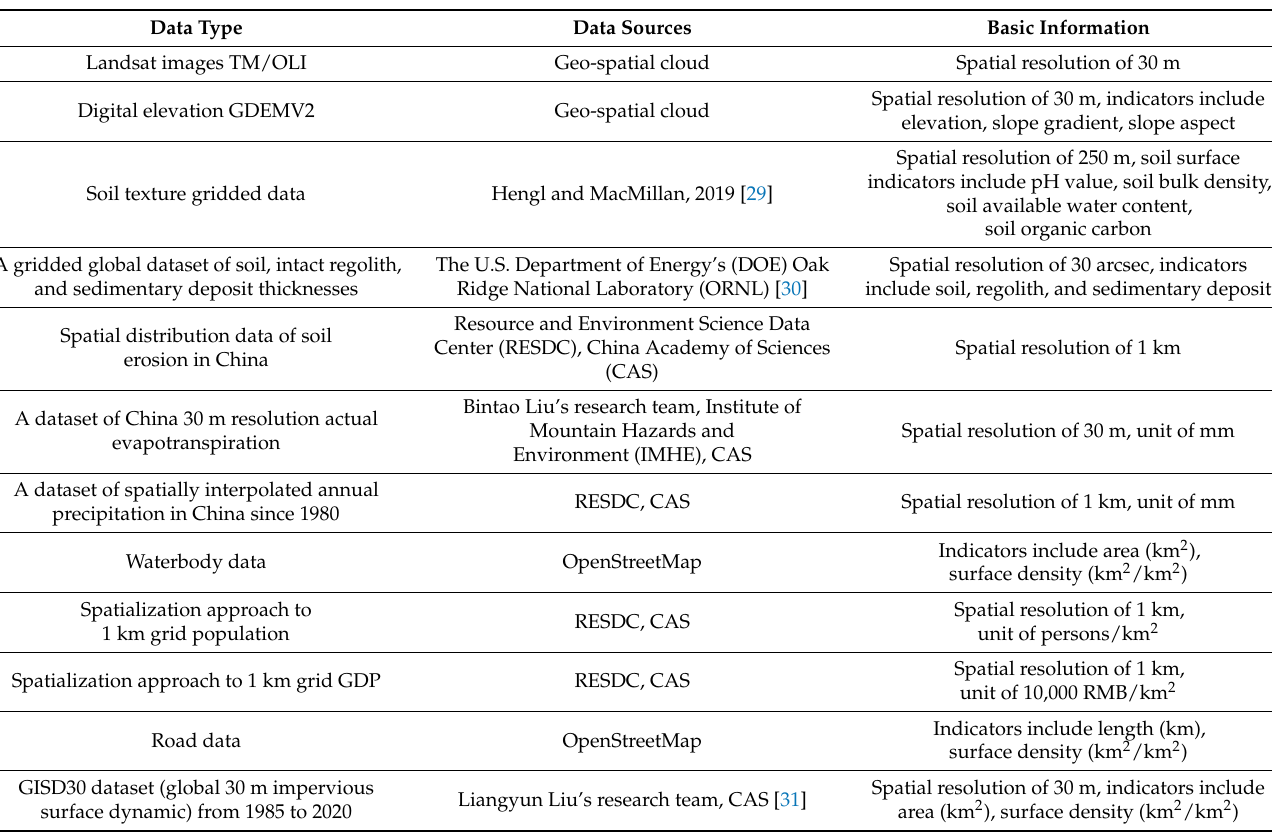
Table 1. Main data sources and basic